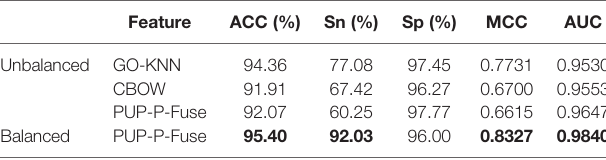
TABLE 2 | The prediction results of different feature extraction and balance methods for predicting pupylation proteins.